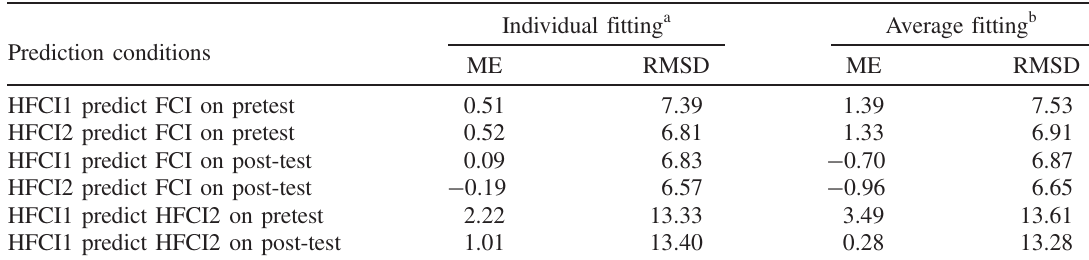
TABLE V. Errors between the predicted scores and the observed scores. All scores are in the scale of 0 –